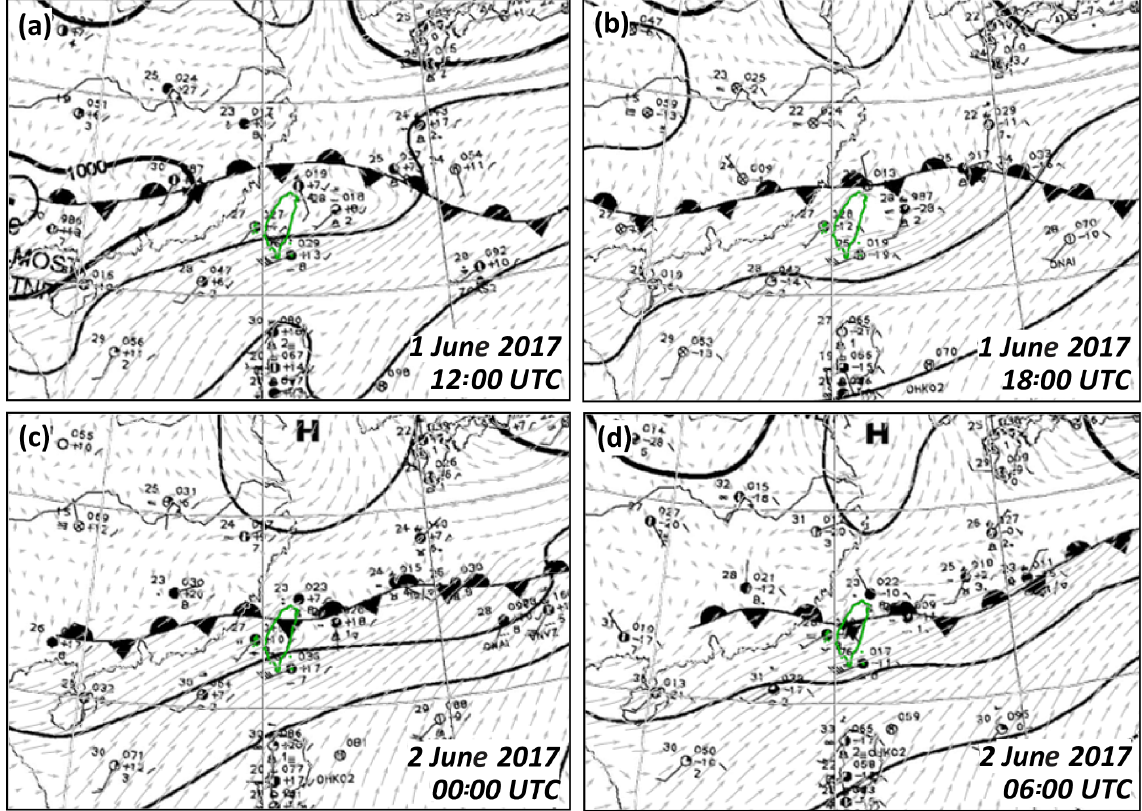
Figure 2. The CWB surface weather charts, overlaid with the NAVGEM 925hPa flow field, surrounding Taiwan every 6h from (a) 12:00UTC on 1 June to (d) 06:00UTC on 2 June 2017. In the panels, the mean sea-level pressure (MSLP,hPa) is analyzed with isobars every 4hPa (thickened at 1000hPa), and the frontal position (and type) and closed high/low centers (labeled as H/L) are marked (source: CWB and the Databank for Atmospheric and Hydrologic Research –